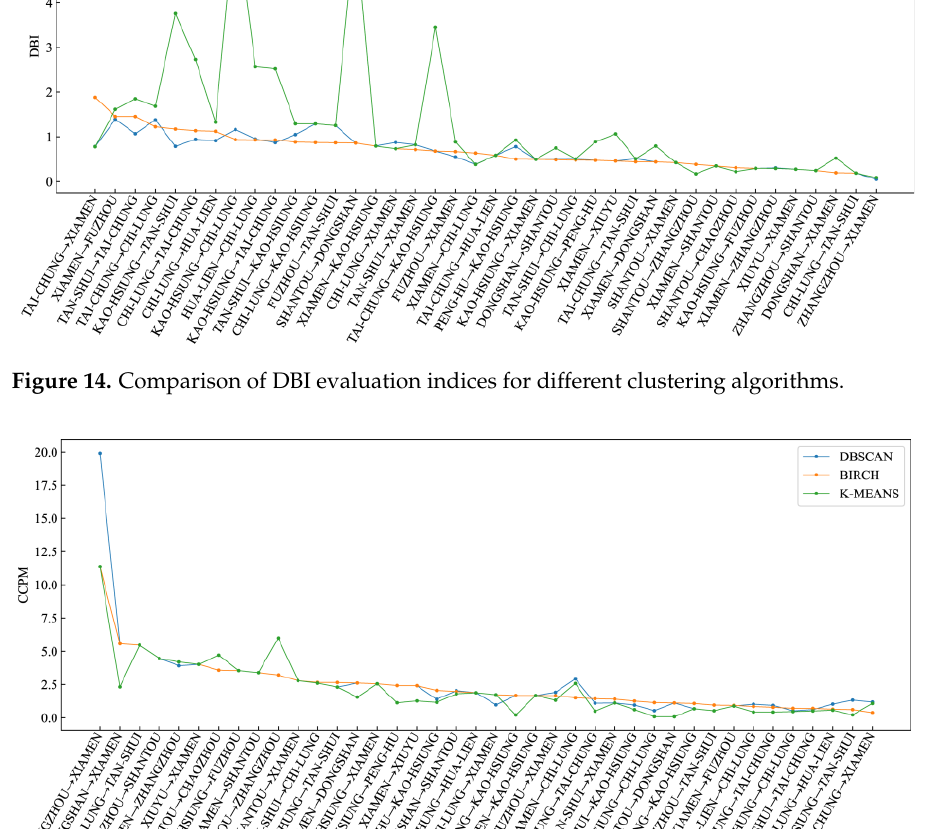
Figure 15. Comparison of CCPM evaluation indices for different clustering algorithms.